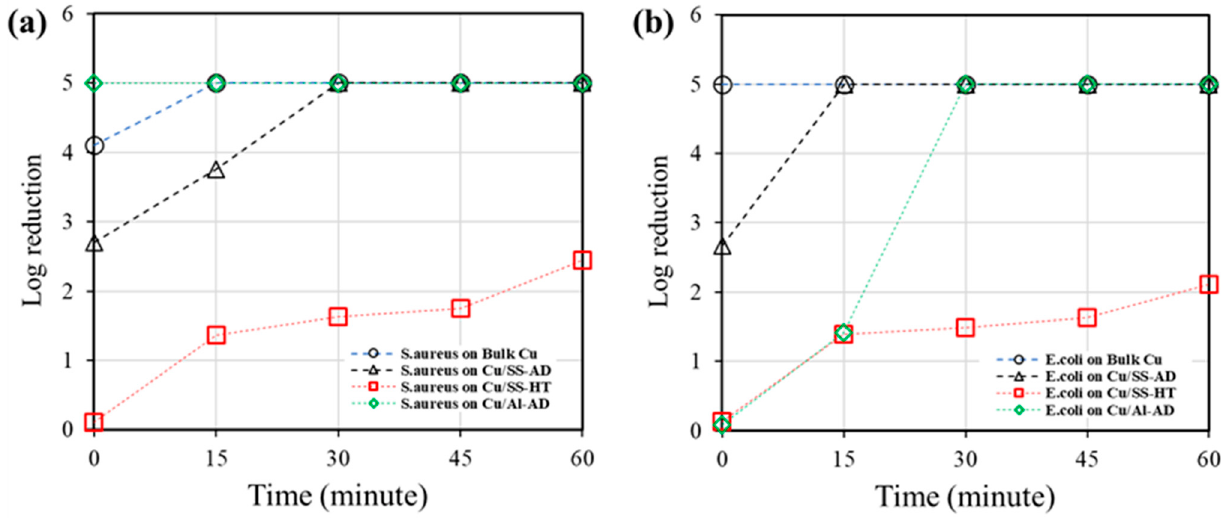
Figure 3. Antibacterial efficacy of bulk Cu and Cu-coated samples against ( a ) S. aureus and ( b ) E. coli. (data represent average value of log reduction of viable counts of recovered bacterial cells). Table 4. Antibacterial efficacy of various samples against S. aureus and E. coli. (data represent average value of log reduc ‐ tion ± standard deviation).